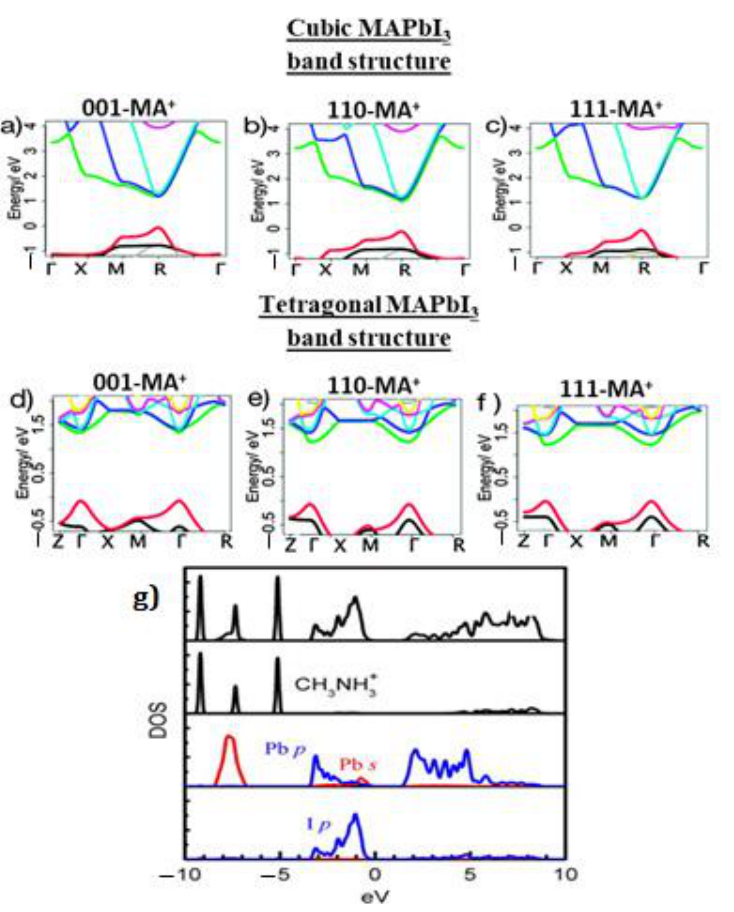
Figure 3. Band–gap structure of a cubic ( a – c ) and tetragonal ( d – f ) MAPbI 3 crystal structure. Total Figure 3. Band – gap structure of a cubic ( a – c ) and tetragonal ( d – f ) MAPbI3 crystal structure. Total and partial density of states of MAPbI3 and ions ( g ) [35,36]. and partial density of states of MAPbI 3 and ions ( g )